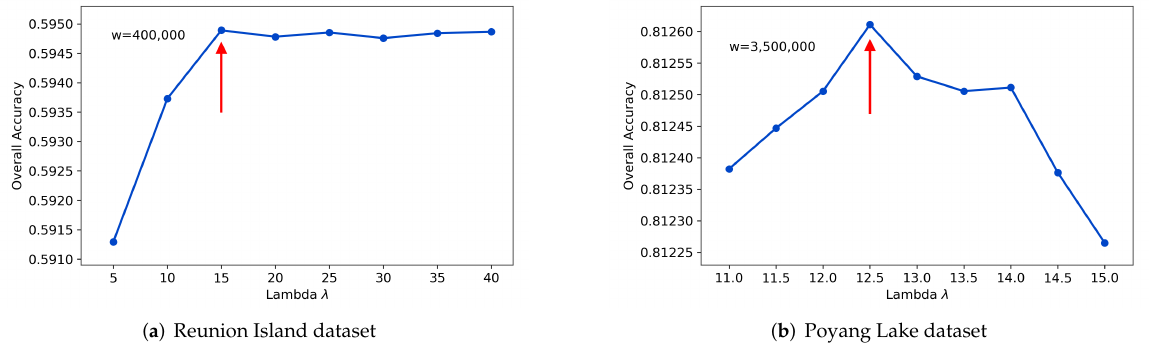
Figure 11. The extraction of parameter λ given fixed w on the two datasets. ( a ) Reunion Island dataset; ( b ) Poyang Lake